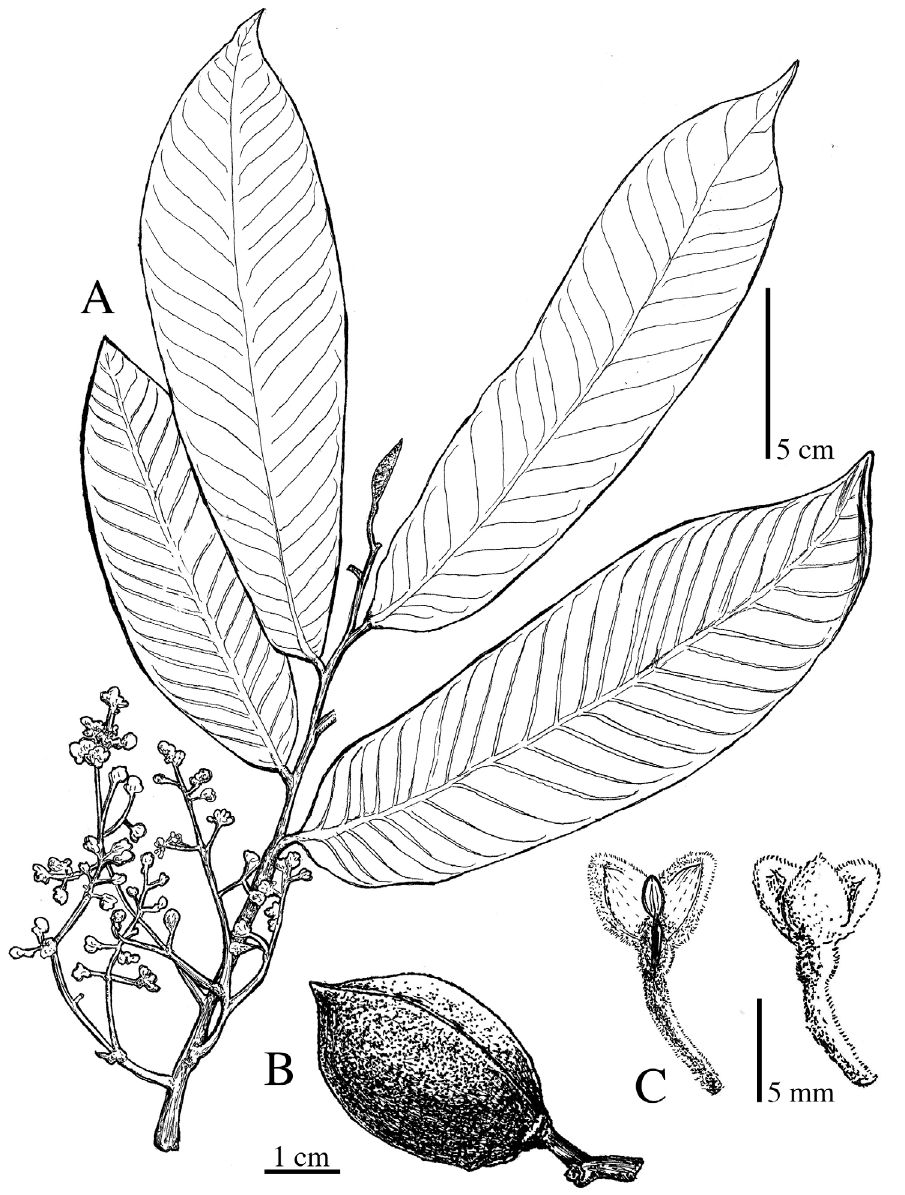
Figure 21. Virola montana A branch with leaves and inflorescences B fruit C flowers. Drawn by Pedro Juarez based on G. Herrera et al. 514 ( A–C ), and R. Lent 3899 ( B branches and are 0.2–0.6 mm long (vs. 3–6 branches 0.05–0.1 mm long), staminate flowers with a shorter filament column (0.6–0.9 mm vs. 1–1.2 mm long) and fruits with a thicker pericarp (3.2–5 mm vs. 0.4–1 [–2.5] mm thick).